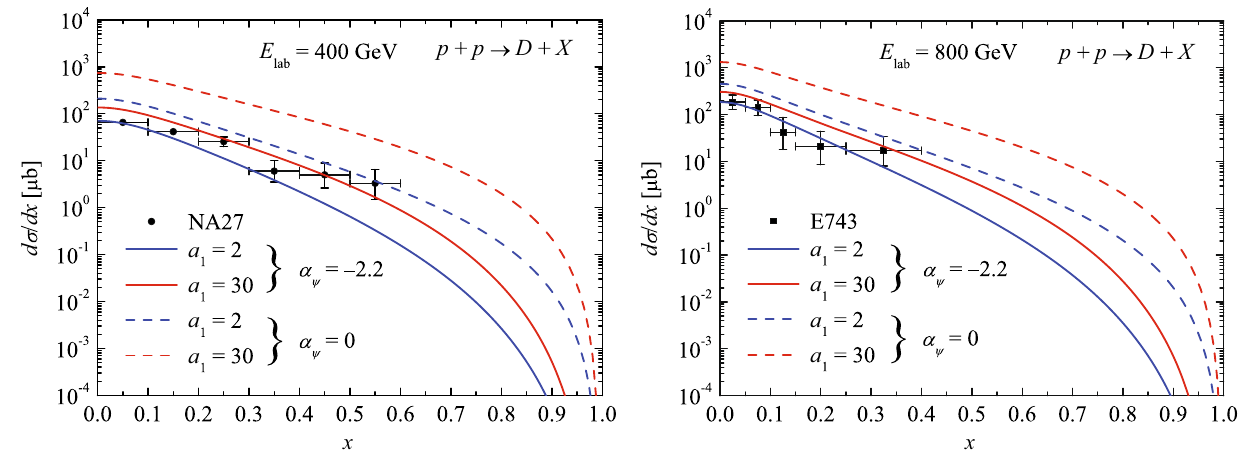
Fig. 2 Differential cross sections of D / ¯ D mesons production in pp collisions at E lab = 400 GeV (left) and E lab = 800 GeV (right). Experimental data: closed circle for [40]; closed square for [41]. Same notation for lines as in Fig.